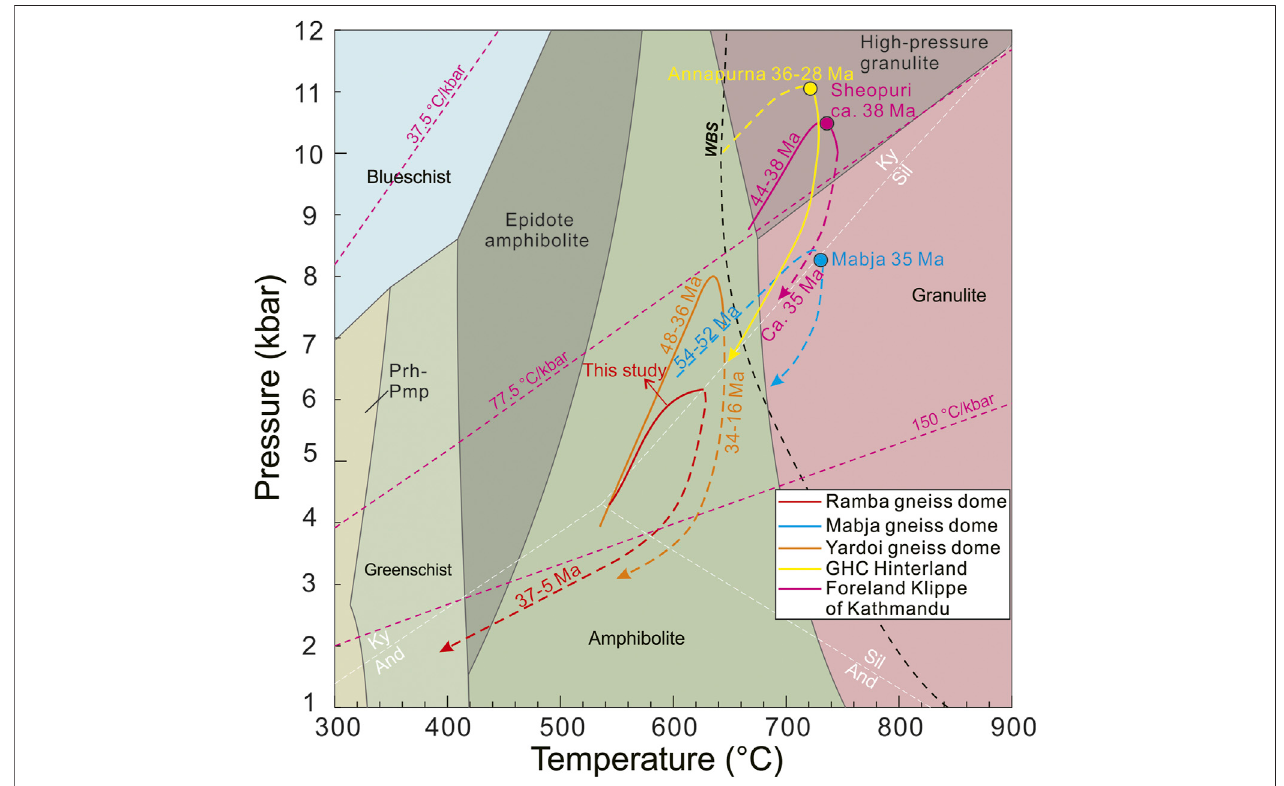
FIGURE10| Summaryof P – T – t pathsofdifferentEoceneunitsacrosstheHimalayas,includingtheRambagneissdomeinthisstudy,theMajbagneissdome(Lee et al., 2004; Lee and Whitehouse, 2007; Smit et al., 2014), the Yardoi gneiss dome (Ding et al., 2016b), Hinterland GHC (Iaccarino et al., 2015), and the Kathmandu Klippe (Khanal et al., 2021). The boundary lines for metamorphic facies are modi fi ed from Palin et al. (2020). UHT — ultrahigh temperature; WBS — wet basalt solidus.